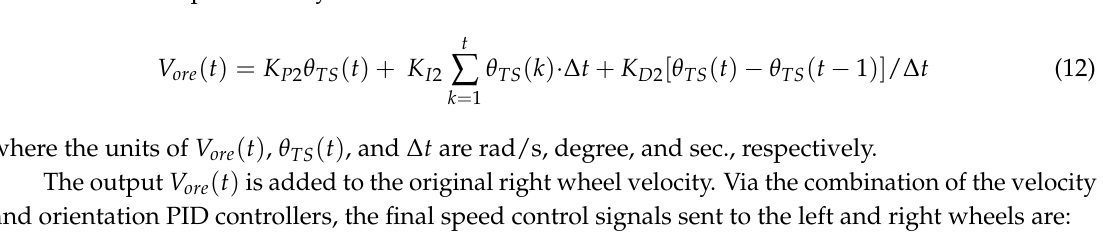
Figure 6. Target seeking angle.